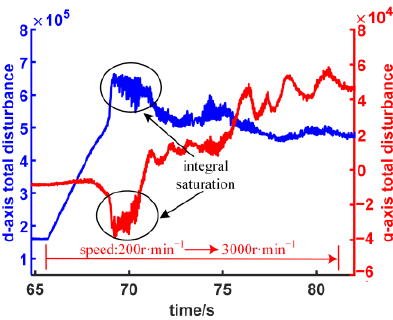
Figure 12. Total disturbance observed value.